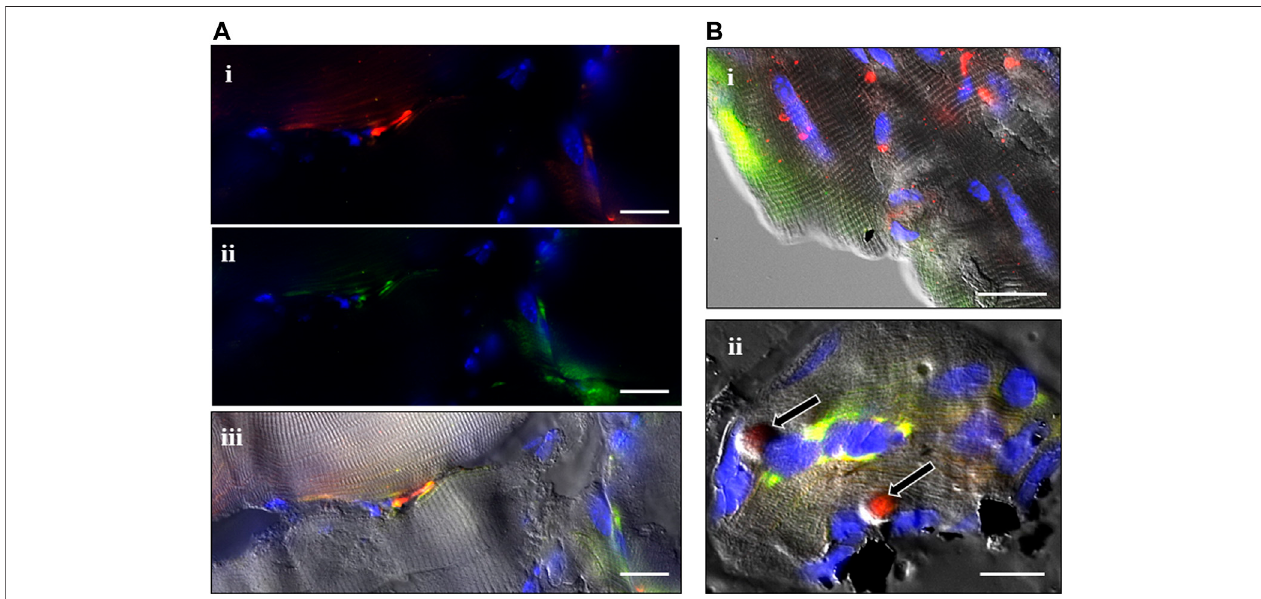
FIGURE2| Combined insitu hybridization (ISH)experimentsandP75immunostaining.Acombinationof fl uorescentISHandimmunostaining wasusedtolocalize the expression of Sema3A (green) and S100B (red) mRNAs and P75 protein (white) in the tibialis anterior muscle at different time points after cardiotoxin (CTX) and muscle-crush(CR)injury,withorwithoutISDNpretreatment (A) .CTX-injuredmuscleatday0(immediatelyfollowingCTXinjectionandafter2daysofISDNpretreatment) showing S100B expression (i, red fl uorescence), Sema3A expression (ii, green fl uorescence), and S100B and Sema3A mRNA signals merged with the differential interference contrast (DIC) image (iii) (B) . Images of ISH signals overlain with corresponding DIC images of the same representative fi elds of control untreated, uninjured muscles (i, ii) showing S100B (red) and Sema3A (green) ISH signals alone (i) or in combination with P75 immunostaining (white) (ii). (Bii) shows two probable terminal Schwann cells (TSCs) identi fi ed at rounded S100B-expressing regions surrounded by P75 protein (arrows). Bars indicate 10 µm (A,Bi) or 5 µm (Bii) .